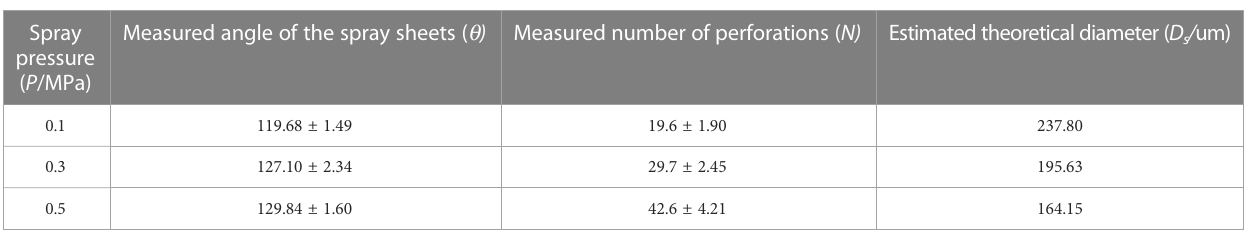
TABLE 2 Theoretical results at different spray